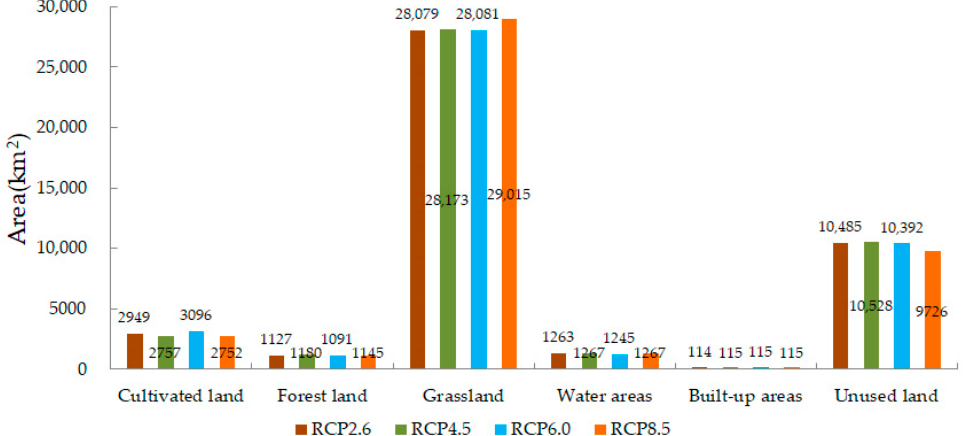
Figure 3. Land use area of Bosten Lake basin in 2050 for RCP scenarios.